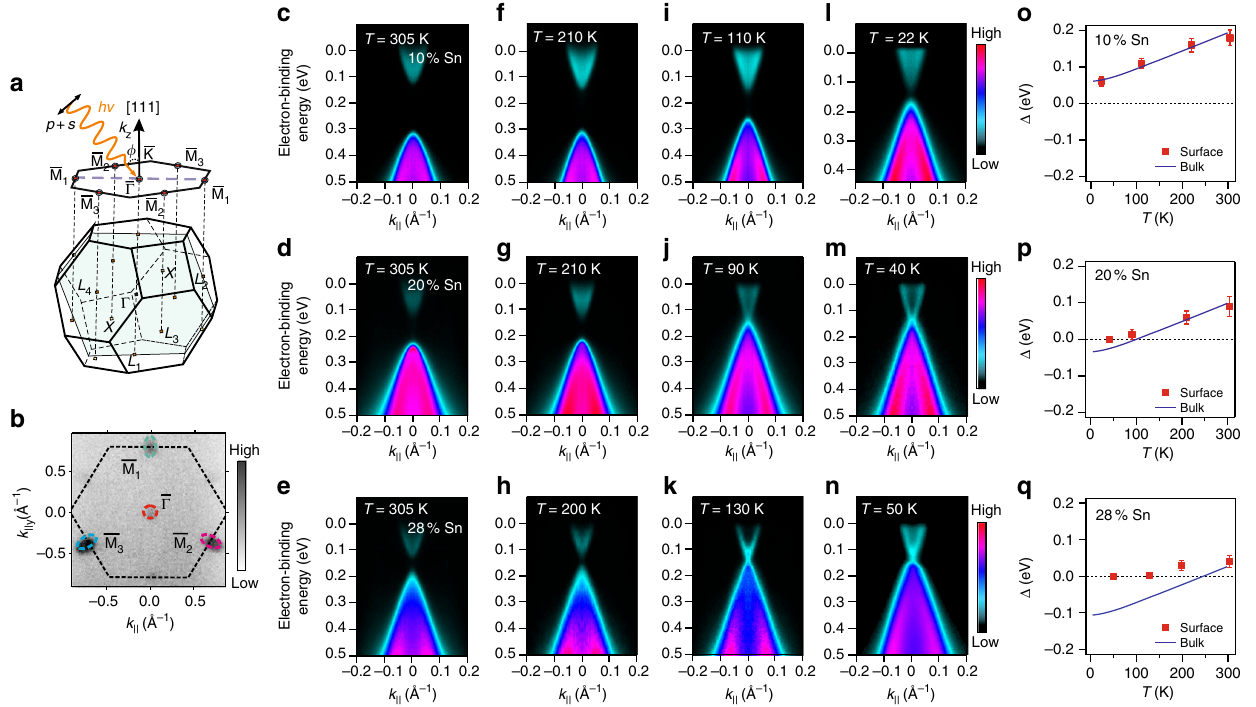
Fig. 1 Trivial to TCI phase transition induced by cooling. The phase transition into a topological crystalline insulator (TCI) is monitored for undoped Pb 1 − x Sn x Se (111) fi lms by ARPES around the Γ point. a For (111) fi lms, the four bulk L -points of the bulk Brillouin zone project onto the surface Γ -point for the longitudinal L -valley along [111], whereas the three oblique valleys project on the M points. b At these momenta, Dirac points appear in ARPES. c – q ARPES data measured at 18 eV photon energy as a function of temperature and Sn content. The x Sn = 10% sample ( c , f , i , and l ) remains trivial down to low temperature as seen from the persistence of a band gap. For x Sn = 20% ( d , g , j , and m ) and 28% ( e , h , k , and n ), gapless Dirac cones develop at low temperature due to the inversion of the bulk band gap. Panels o – q show the comparison of the measured surface (Dirac cone) band gap (red squares) with the bulk band gap (blue line) from optical data 27 , evidencing that the surface gap closes when the bulk band gap changes sign. The error bars in the measured surface band gap correspond to the uncertainty in determining the energy position of the band dispersions at the Γ -point (see Supplementary Note 6 for details). The ARPES dispersions were acquired using linearly polarized p + s photons incident on the sample under an angle ϕ = 45° as shown in a (see also Supplementary Note